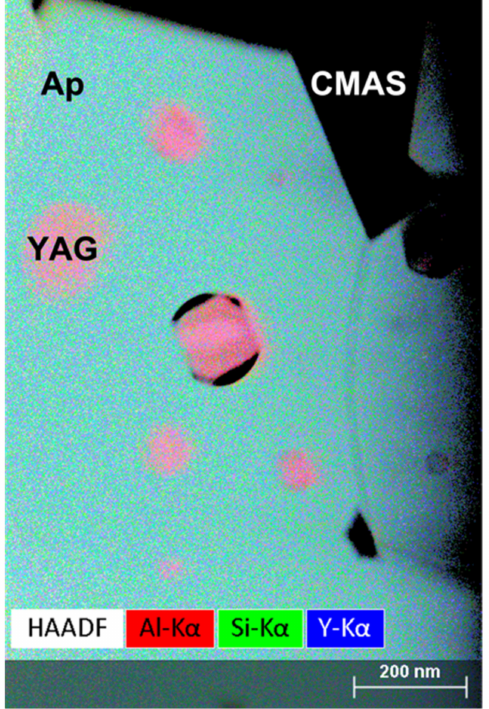
Figure 7. EDS map overlaid on HAADF image showing the phases in the reaction region of the (101) YAP sample exposed to CMAS for 30 min at 1350 ◦ C. The TEM sample was extracted from a region similar to that indicated in Figure 5k. The EDS map combines the signals of Al, Si, and Y, represented in red, green, and blue, respectively; grayscale indicates HAADF contrast. The label G indicates the